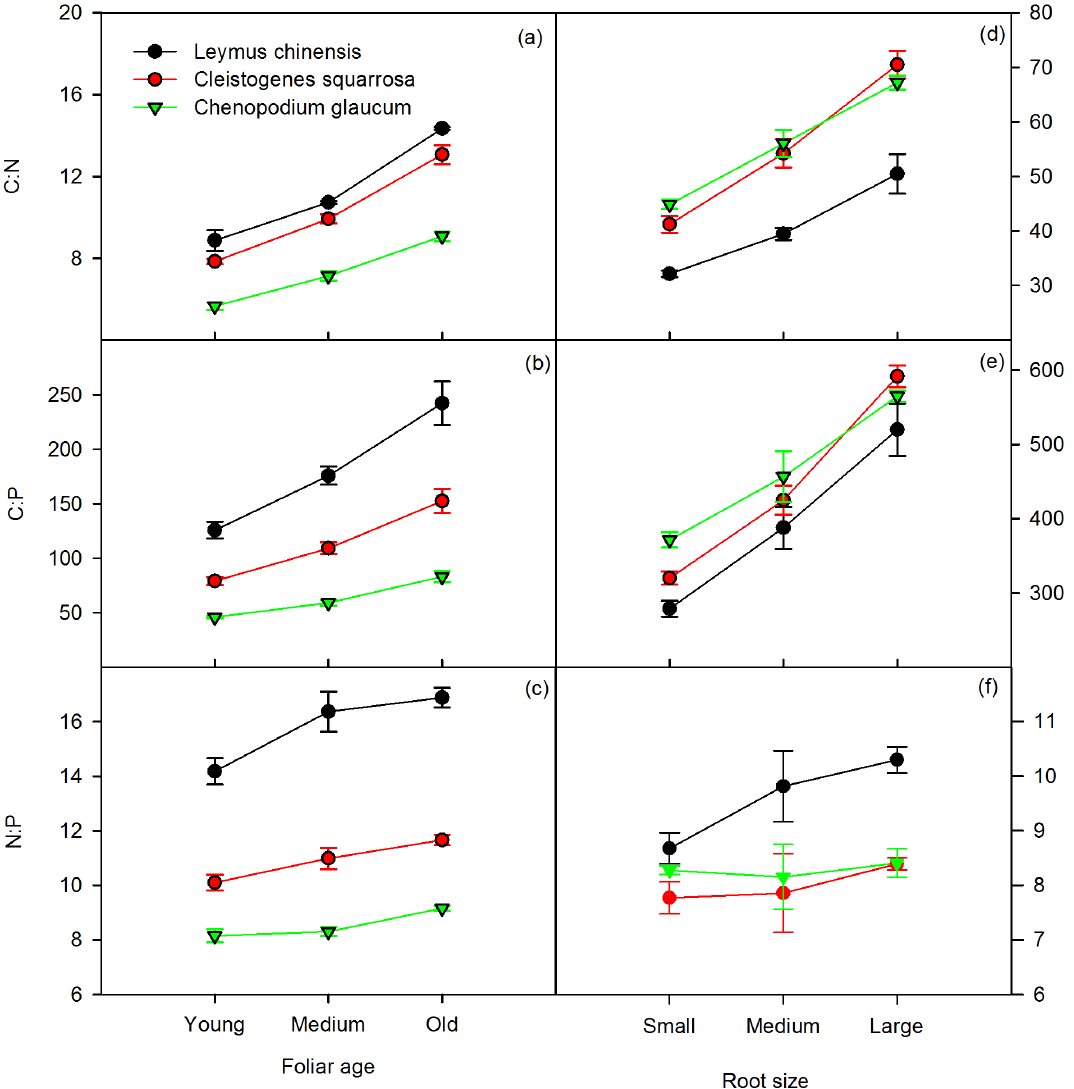
Figure 2. Mean C:N, C:P, N:P ratios for foliage of different ages (young=emerging; medium=fully expanded at midpoint of plant; old=fully expanded at base of plant) (left) and roots in different size categories (small= W # 2 mm; medium=2 mm , W , 5 mm; large= W $ 5 mm) (right). Error bars are SEM.